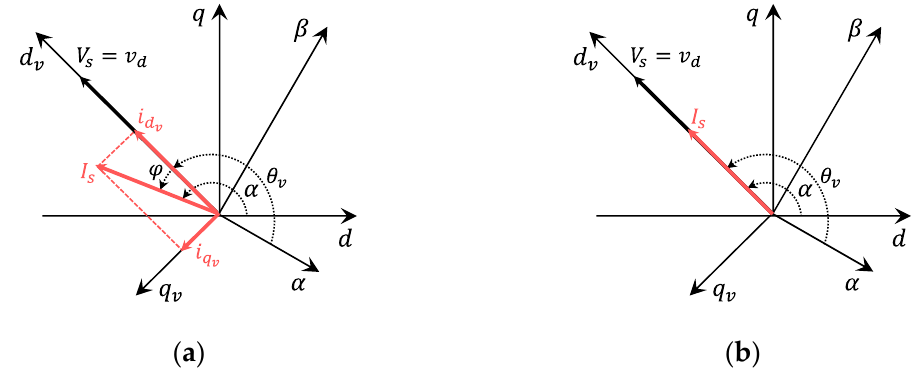
Figure 17. Vector diagram of PMSM: ( a ) φ > 0 (cos φ < 1); ( b ) φ = 0 (cos φ = 1).